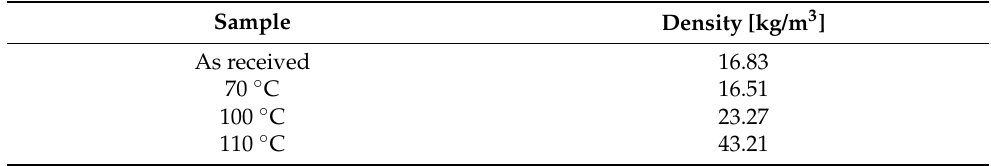
Table 2. The measured densities of the